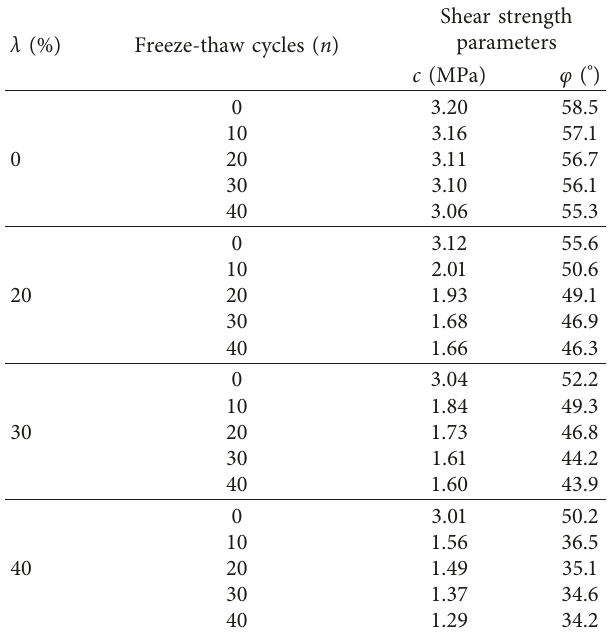
Figure 11: Relationship between joint peak shear stress and persistency and normal stress under freezing-thawing cycles. Table 1: Shear strength parameters of joint specimens before and after freezing-thawing